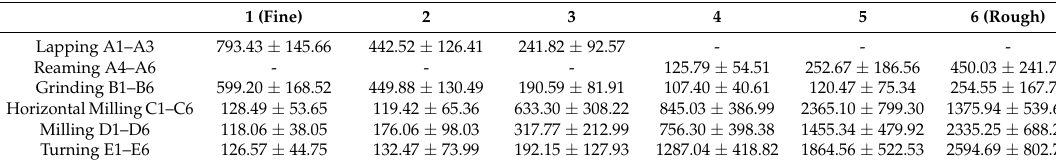
Table 1. Averaged squared deviations between PSD functions in (db/rad) 2 .